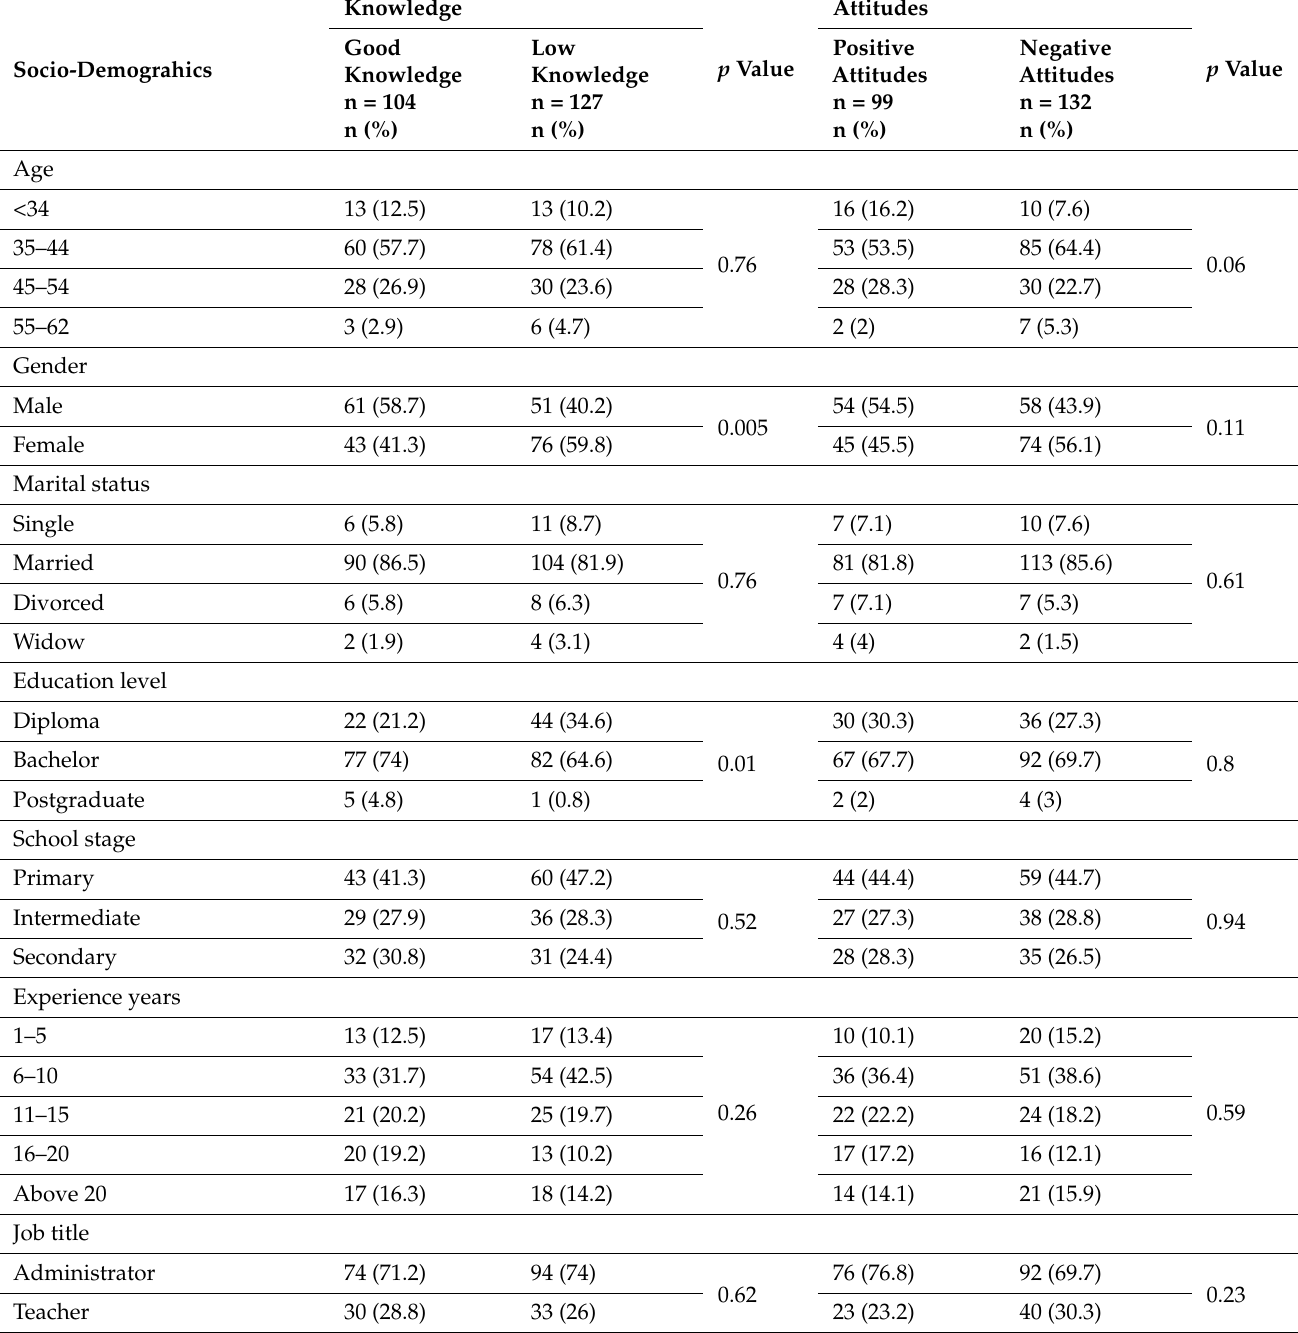
Table 4. Socio-demographics associated with health educators’ knowledge and attitudes toward vitamin